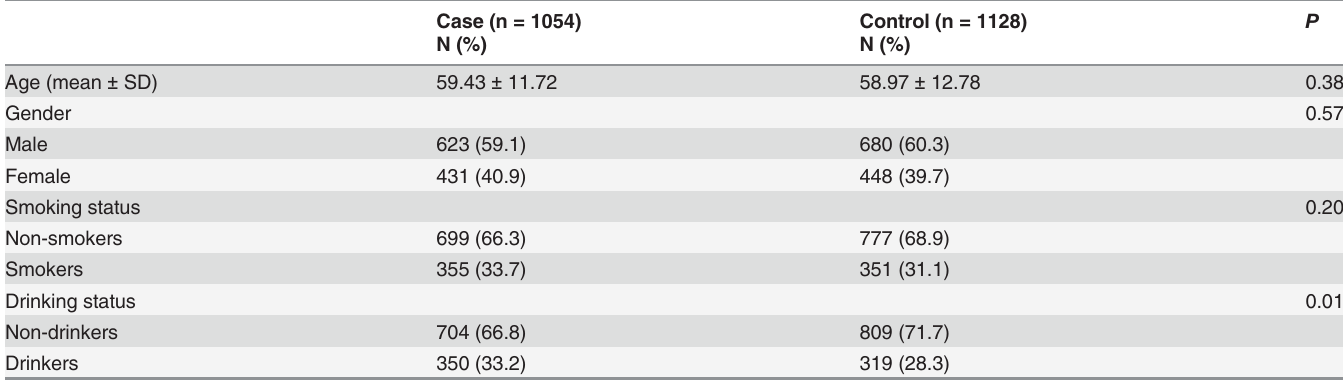
Table 1. Characteristics of participants in this case-control study.